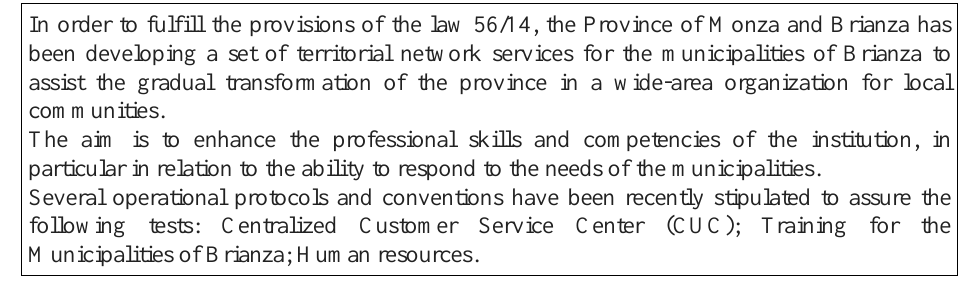
Table 2: Territorial Network Services Projects In order to fulfill the provisions of the law 56/14, the Province of Monza and Brianza